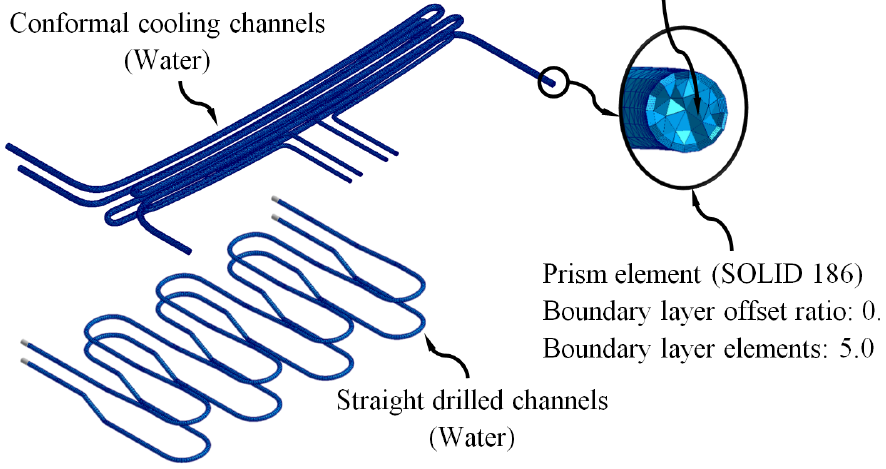
Figure 10. Cooling system meshes.